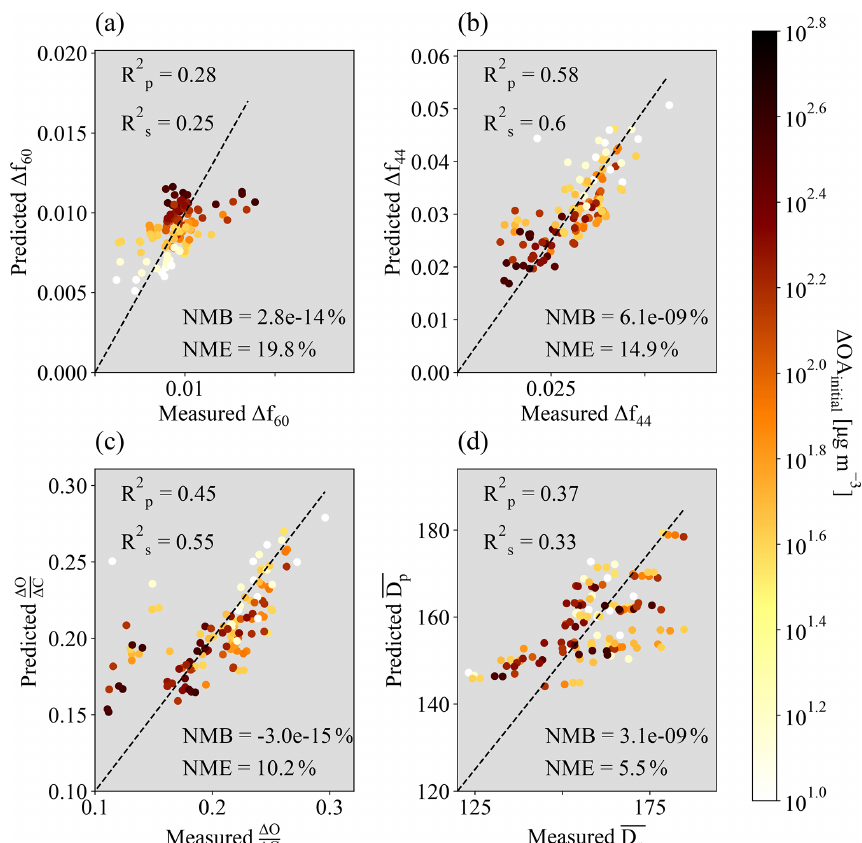
Figure 3. Measured versus predicted (a) (cid:49)f 60 , (b) (cid:49)f 44 , (c) (cid:49) O /(cid:49) C, and (d) D p between 40–262nm. The predicted values are from the equation X = a log 10 ( OA initial ) + b( Physical age ) + c , where X = (cid:49)f 60 , (cid:49)f 44 , (cid:49) O /(cid:49) C, or D p . The values of a , b , and c are provided in Table S3. The Pearson and Spearman coefficients of determination ( R 2 p and R 2 s , respectively) are provided in each panel, along with the normalized mean bias (NMB) and normalized mean error (NME). Note that Fig. 2 provides R values rather than R 2 to provide information on the trend of the correlation. Included in the fit and figure are points from all four (cid:49) CO regions within the plume (the 5%–15%, 15%–50%, 50%–90%, and 90%–100% of (cid:49) CO), all colored by the mean (cid:49) OA initial of each (cid:49) CO percentile